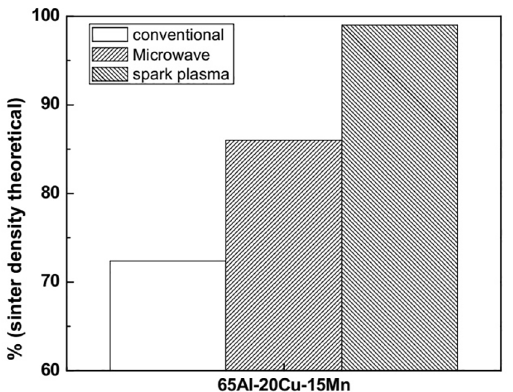
Figure 1. Sinter density with respect to heating mode and composition